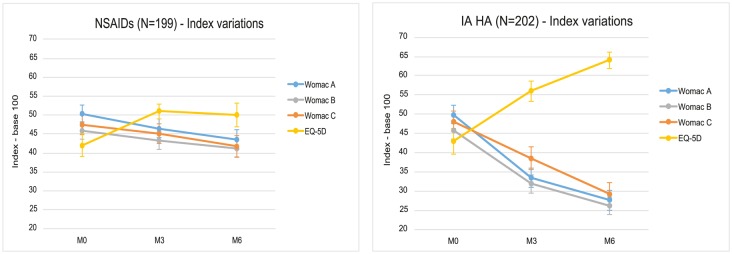
Index variations, for each group NSAIDs or IA HA.Index values for WOMAC A, B, C and for Quality of Life EQ-5D are represented at each observation time, from M0 (inclusion) to M6. All are given in base 100 to allow comparison, and the 95% CI intervals are represented as well. From baseline, a patient improvement is proven by a reduction for any WOMAC index, and by an increase for the EQ-5D. It is obvious that all indexes are clearly improved with IA HA, with a significant difference over NSAIDs.